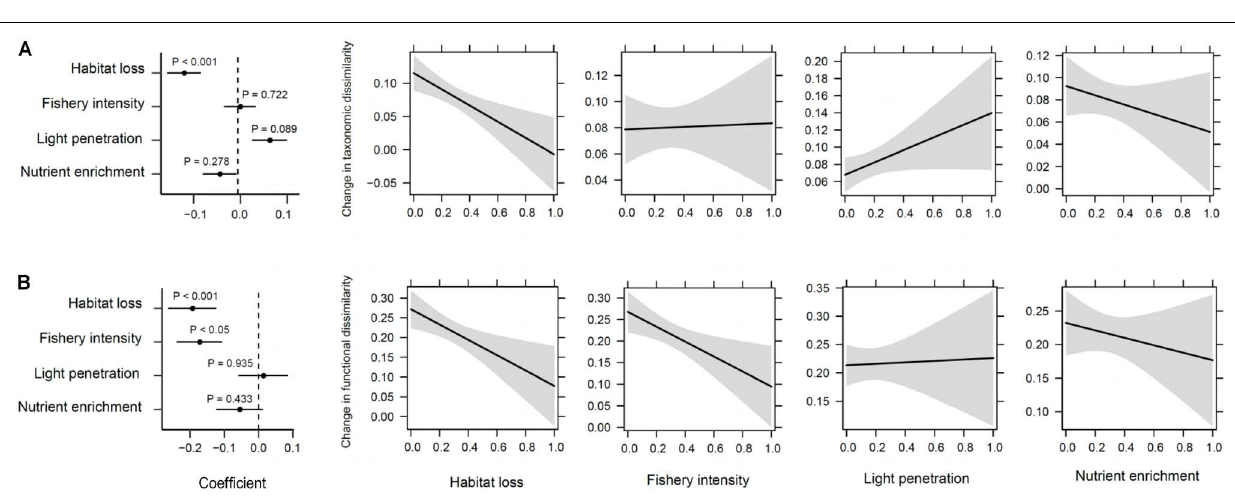
FIGURE 8 | Human impacts on changes of taxonomic and functional dissimilarity. (A) Taxonomic dissimilarity, and (B) functional dissimilarity showing from left to right the correlation coefficients and their significance from a permuted multiple regression on distance matrices, and the estimated marginal effects and confidence intervals of human impacts (i.e., habitat loss, fishery intensity, light penetration, and nutrient enrichment in